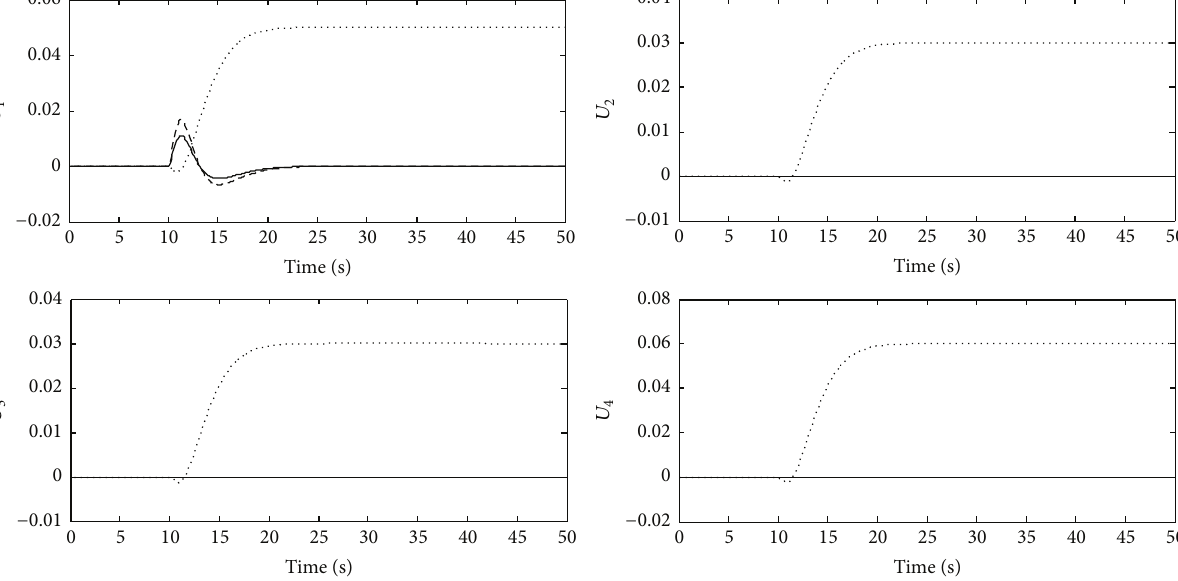
in area 1 (solid line), Δ𝑃 𝑐𝑖 in four areas (dotted line), and Δ𝑇 𝑔 in area 1 (dashed